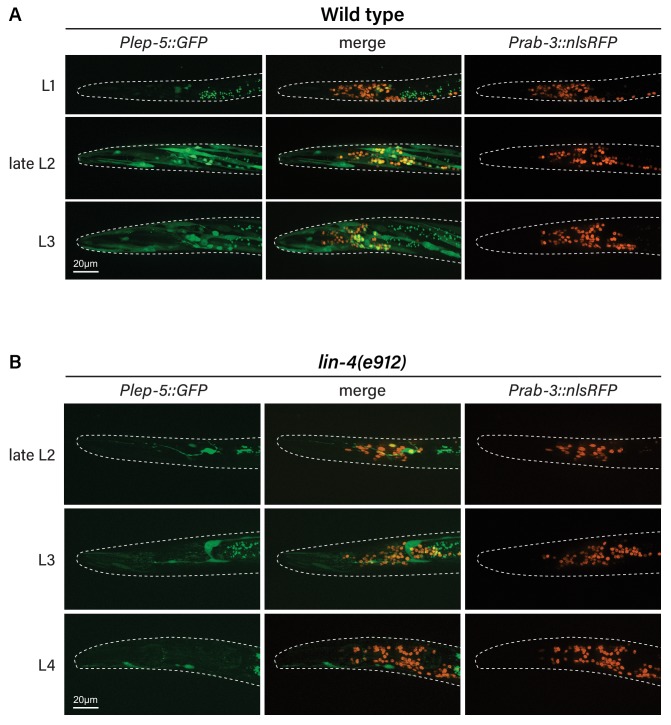
lin-4 is necessary for proper lep-5::GFP expression in the nervous system.Images show expression of the Plep-5::GFP reporter (left), the pan-neural nuclear marker Prab-3::nlsRFP (right) and the merged image (center) in the indicated stages of (A) wild-type and (B) lin-4(e912) mutants. Dashed lines indicate the body outline. The images in (A) are of the same individual as in Figure 3C, shown here in wider-view versions.